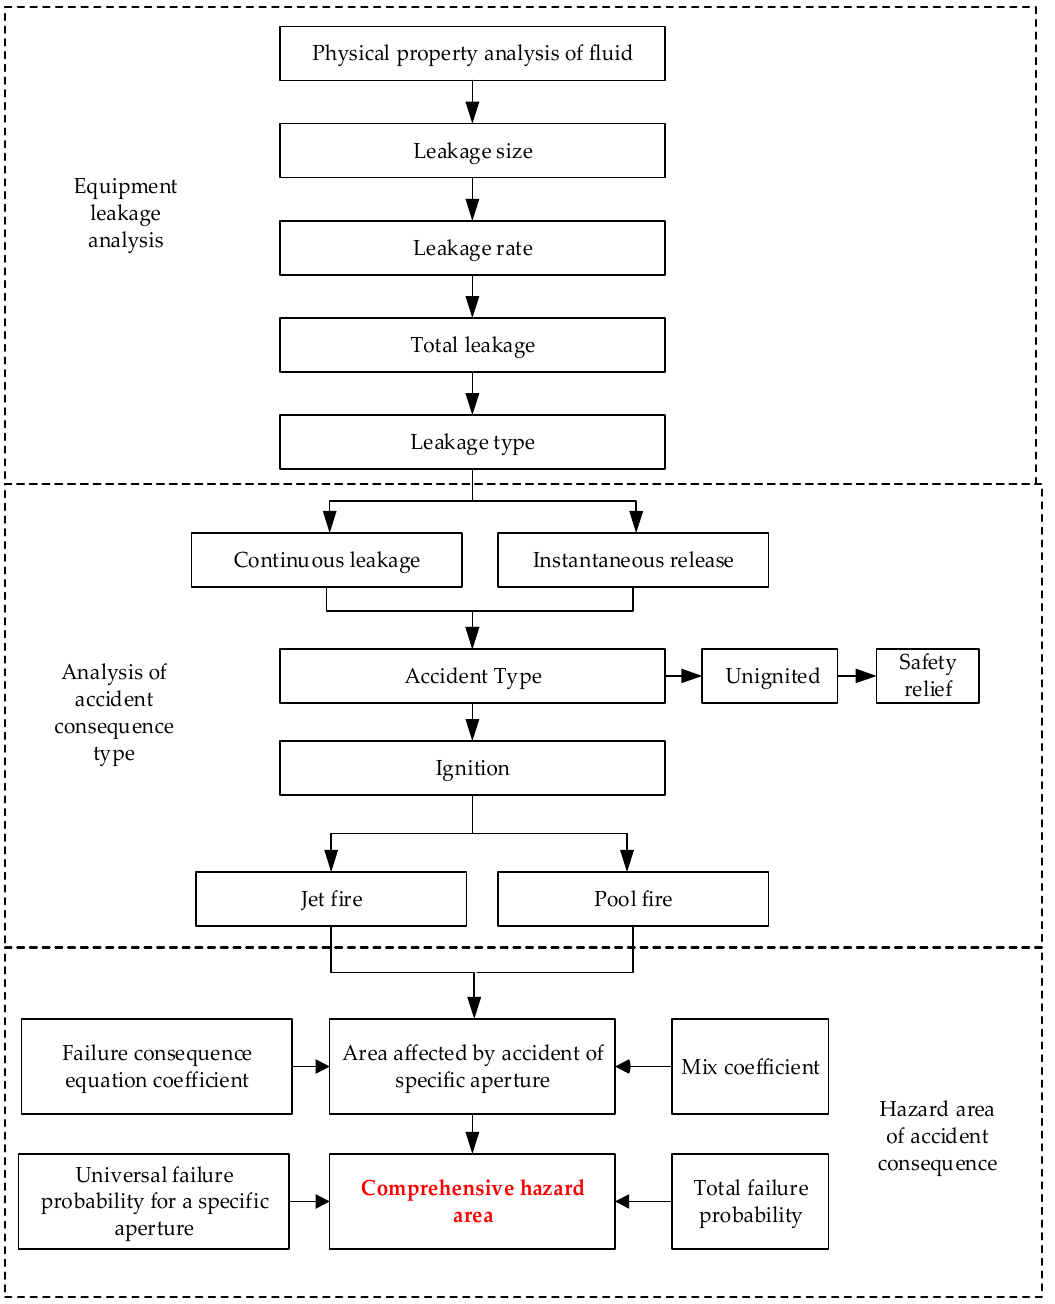
Figure 1. Quantitative theoretical calculation process of accident influence range.